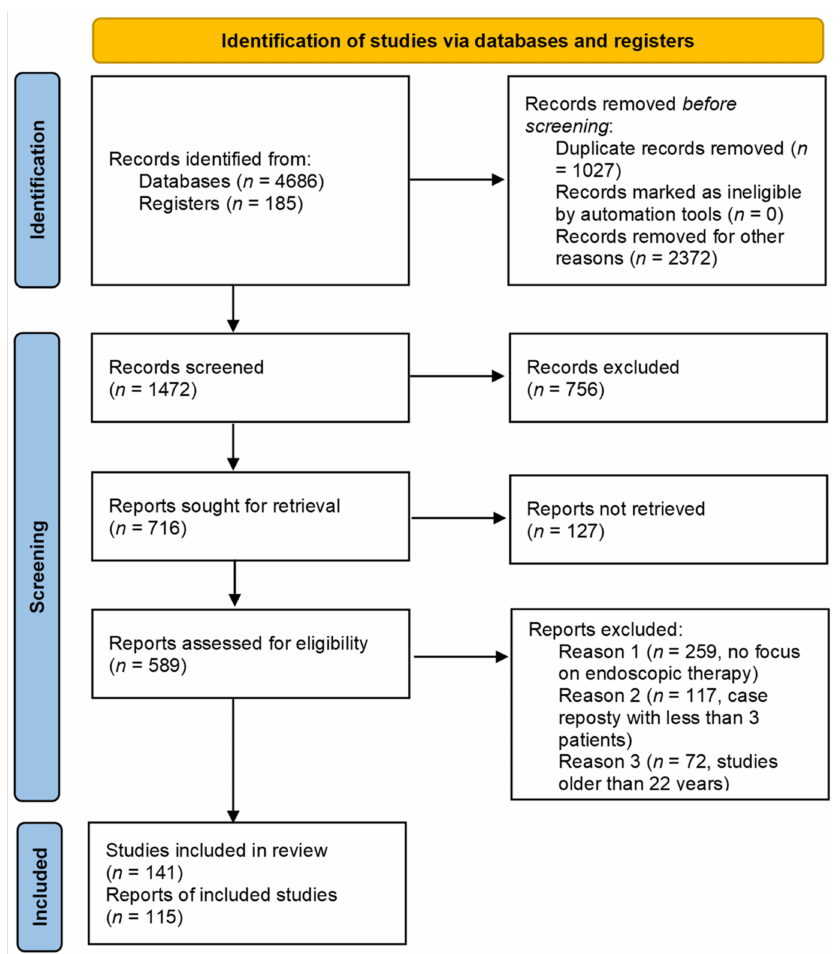
Figure 1. PRISMA 2020 flow diagram for the review